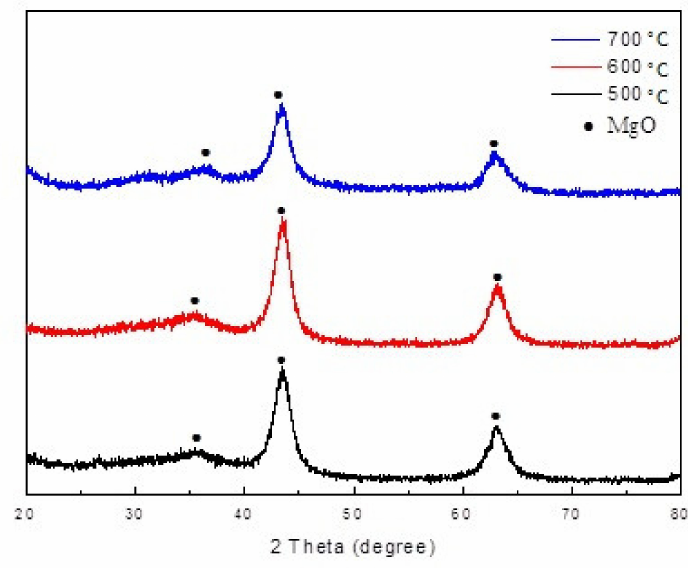
Figure 5. XRD pattern of filter paper-templated Mg-Al metal oxides.